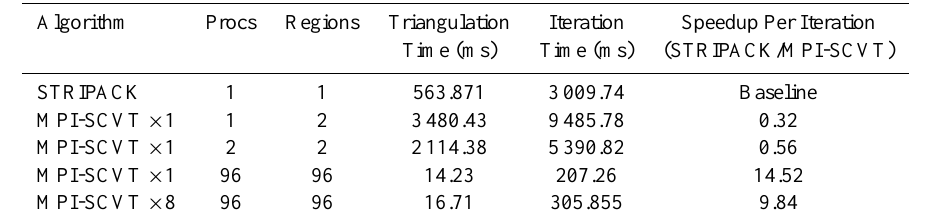
iterations. The green dashed line represents the portion of the code that computes the centroids of Fig. 7. Different views of the same variable resolution grid created using the density function (6). Figure 7(a) the Voronoi regions whereas the red solid line represent the portion of the code that computes the shows the coarse region of the grid, 7(b) shows the transition region, and 7(c) shows the fine region. Delaunay triangulation. In Sect. 4.1, we showed that MPI-SCVT performs comparably to STRIPACK when computing a single full triangulation. However, computing a full triangulation is only part of the story. For SCVT 385 in Sect. 2.3. When using STRIPACK, the full triangulation needs to be computed at every iteration,